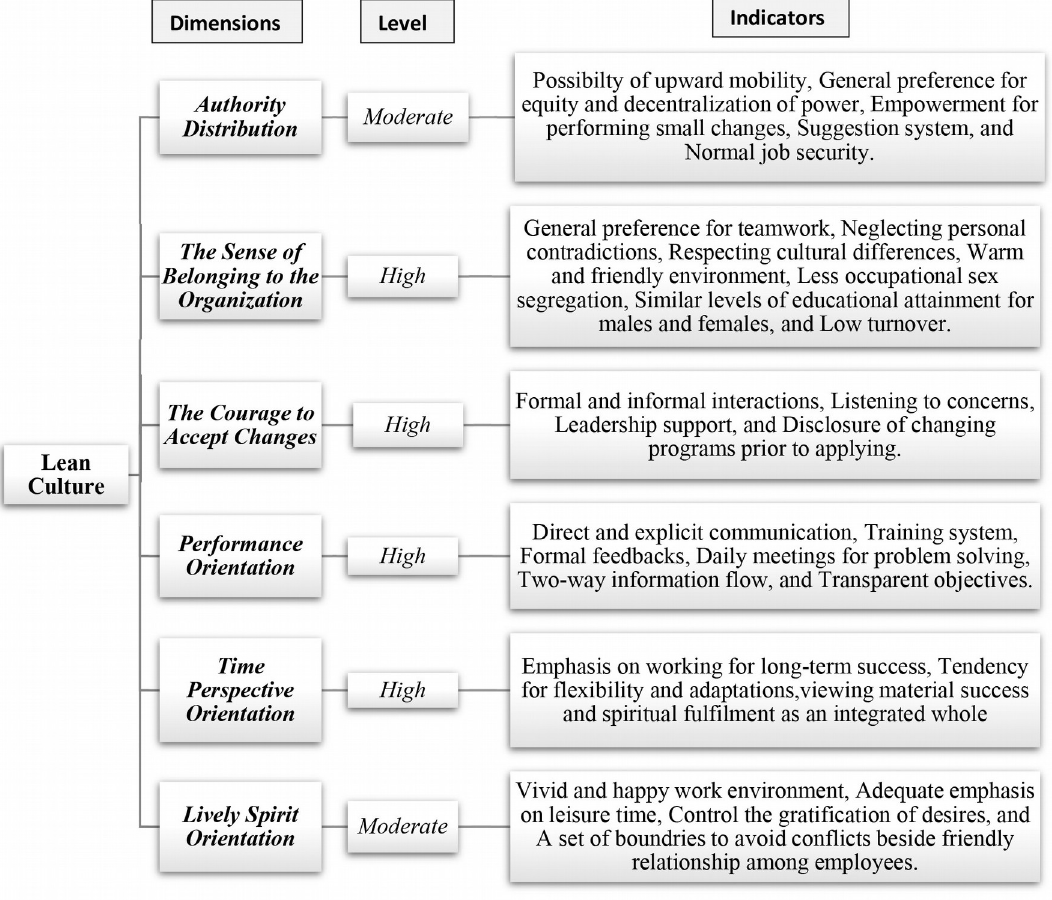
Figure 1. Evaluation